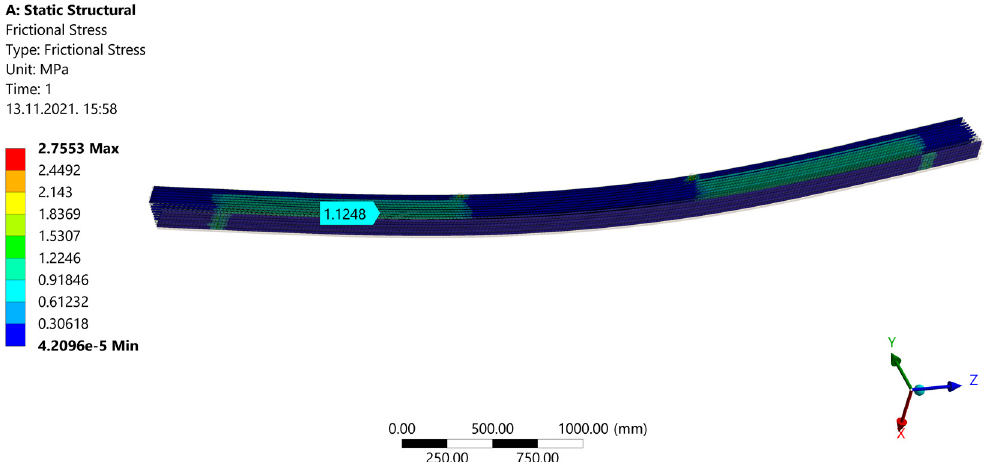
Figure 31. Normal stress.